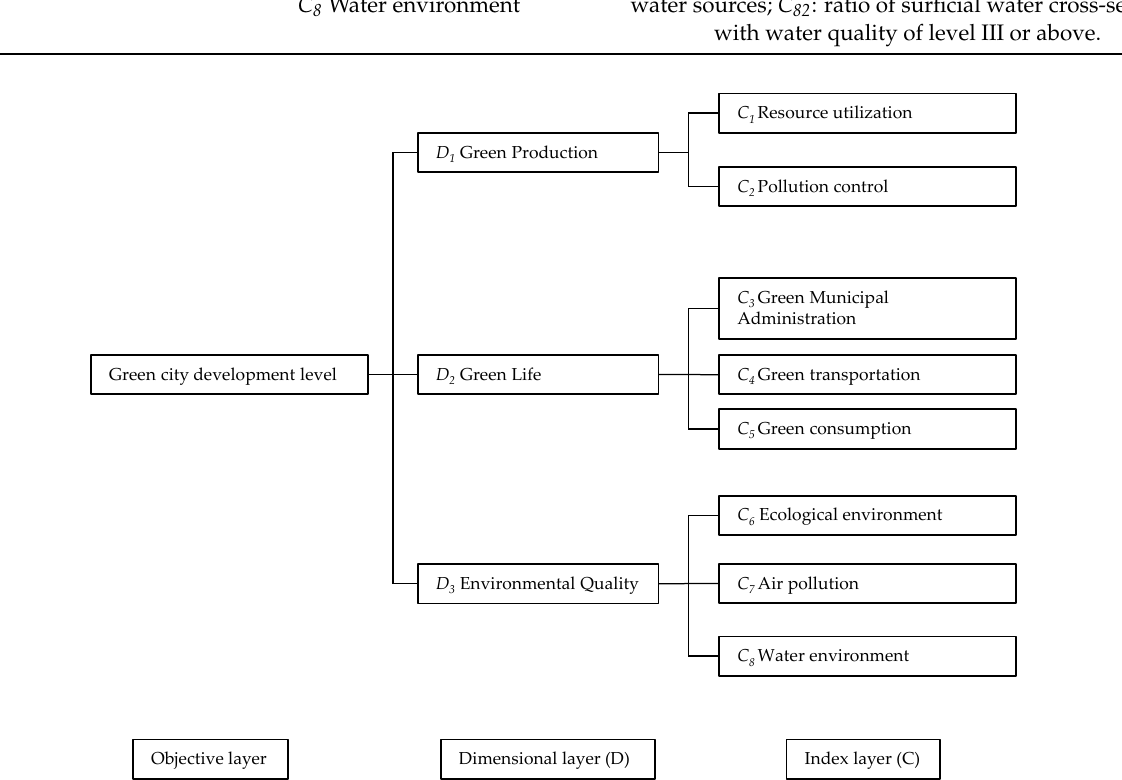
Figure 2. Framework for the indicator evaluation system for the level of sustainable development of green cities.